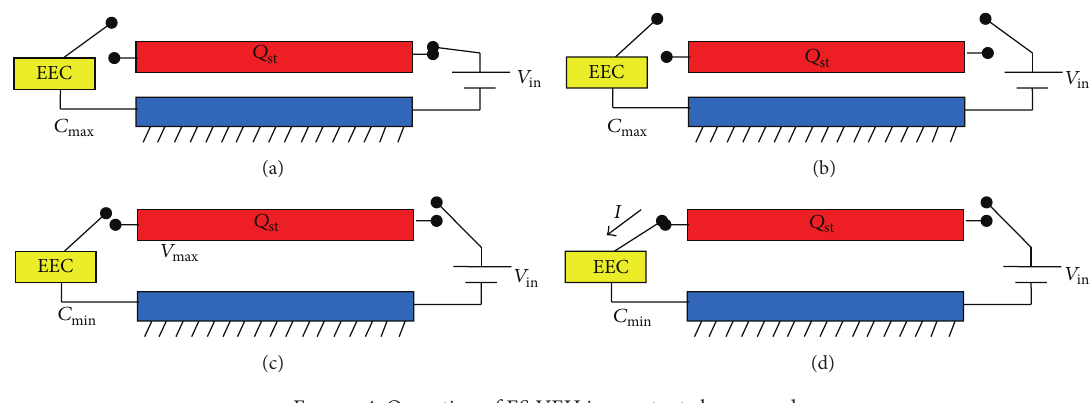
Figure 4: Operation of ES-VEH in constant charge